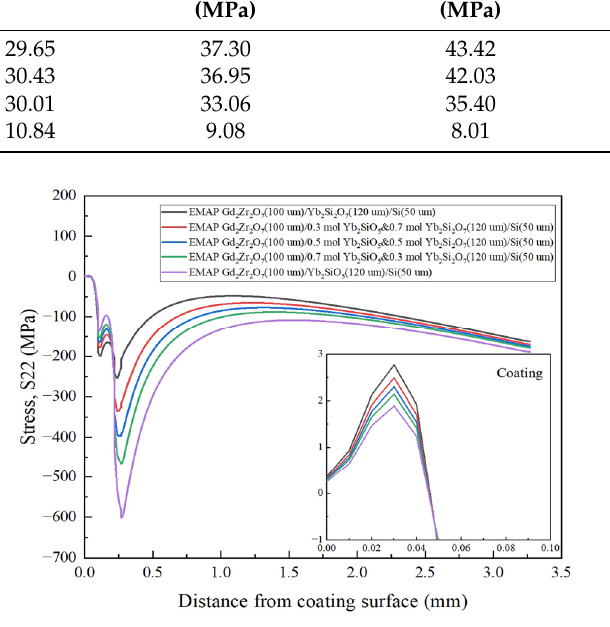
Figure 15. Effect of Yb 2 SiO 5 content on the S22 stress distributions along the right boundary